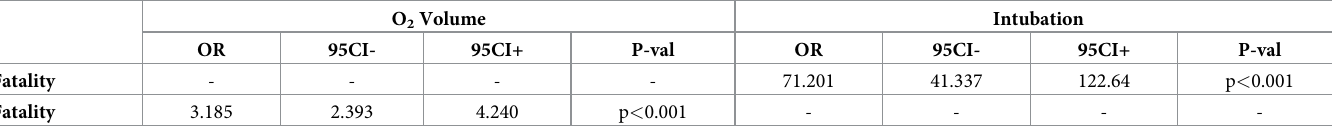
Table 3. Binomial logistic regression odds ratios predicting fatality from oxygen volume requirement and